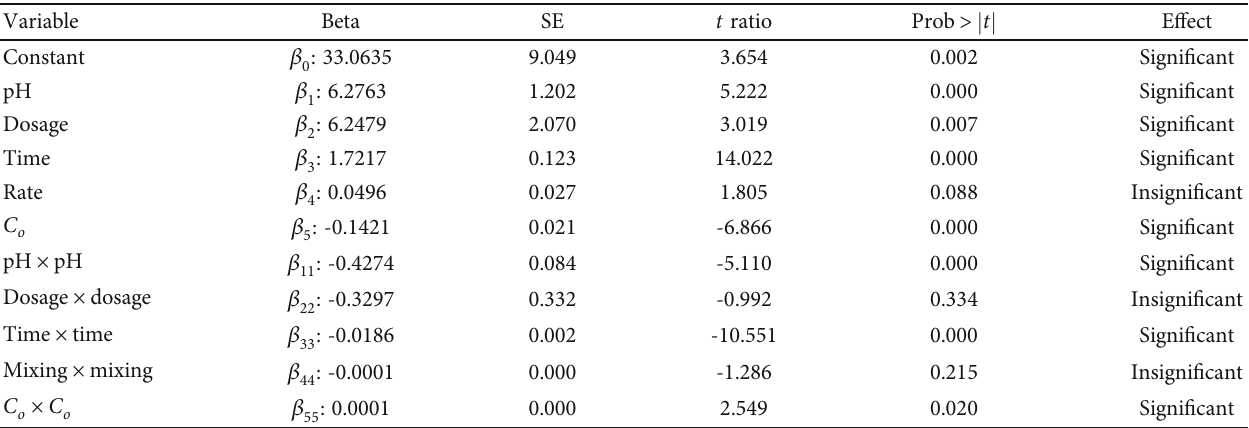
Table 5: t statistics and p values for coe ffi cients of the quadratic regression model to predict BOD removal e ffi ciency. Signi fi cant level at p < 0 : 05 . Goodness-of- fi t indices are R 2 = 0 : 973 and Adj- R 2 = 0 : 959 , with MSE = 3 : 096 and DFE = 18 . Variable